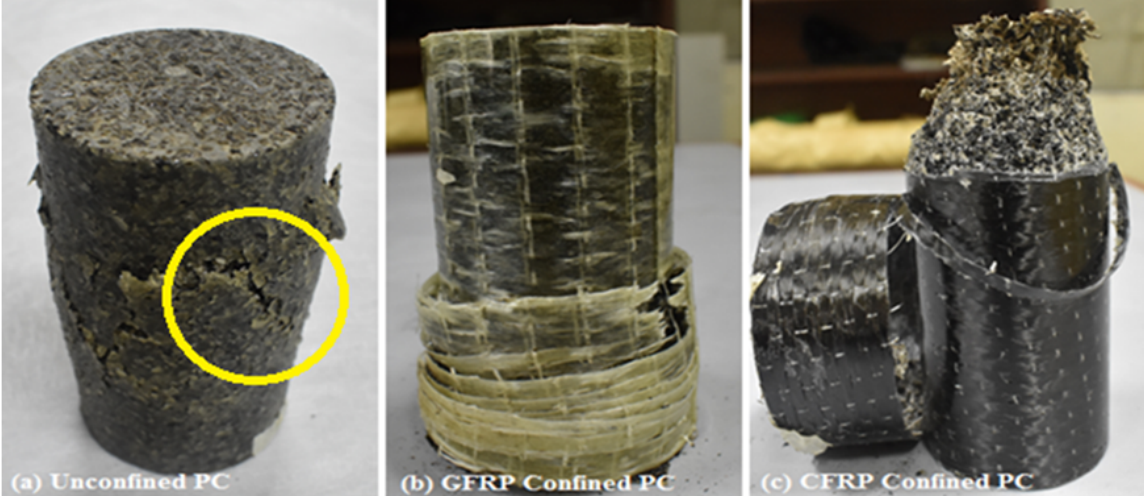
Figure 12: Characteristic failure modes of (a) unconfined PC (b) GFRP confined PC and (c) CFRP confined PC